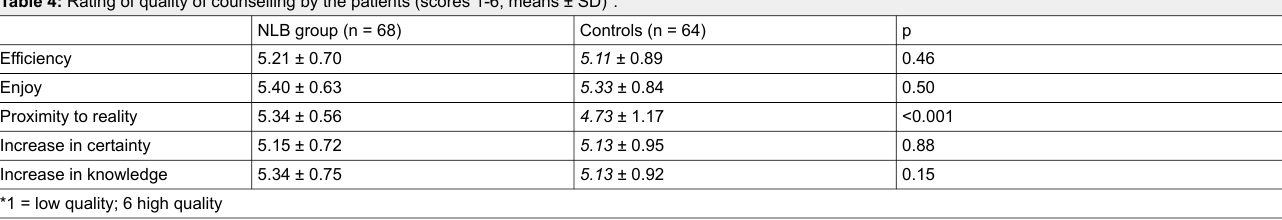
Table 5: Rating of quality of counselling by the dieticians (scores 1–6; means ± SD)*.